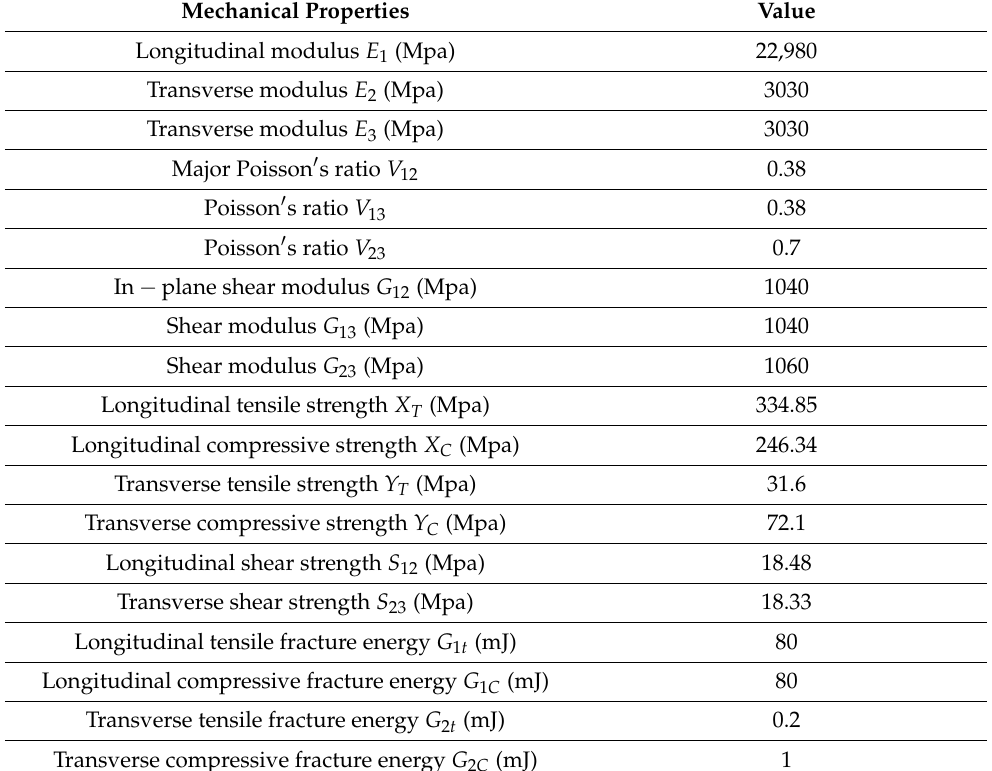
Table 3. Material properties of the